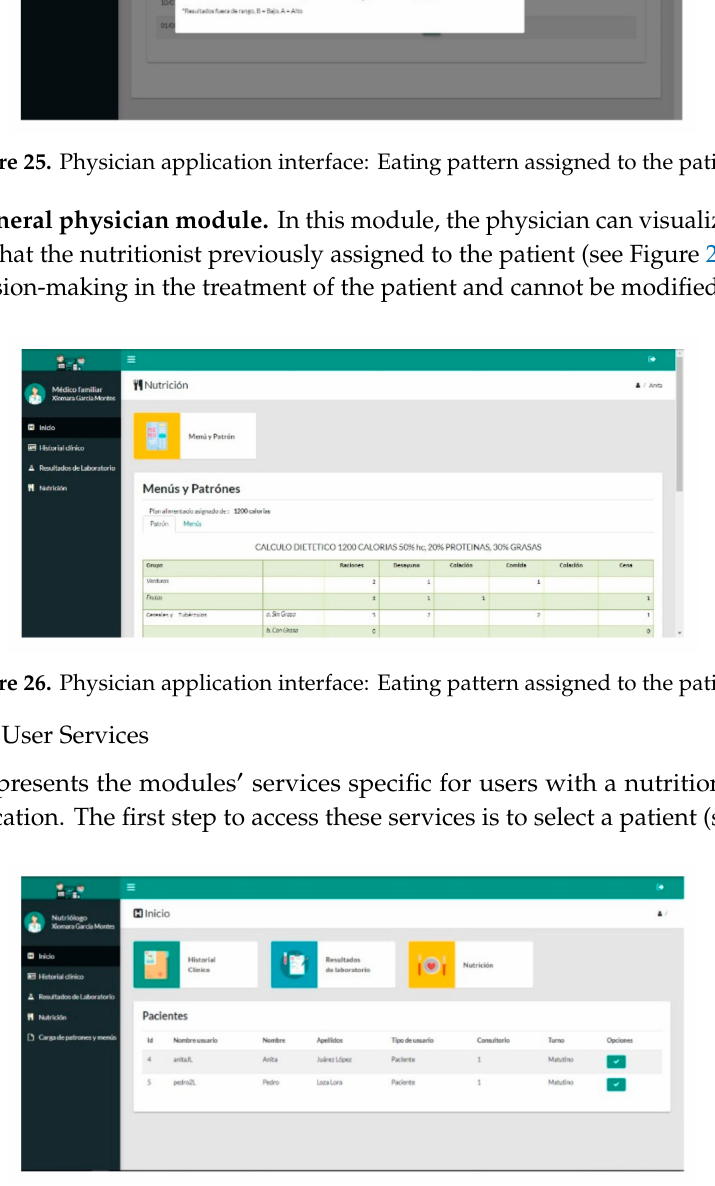
Figure 27. Physician application interface: Main menu of the nutritionist